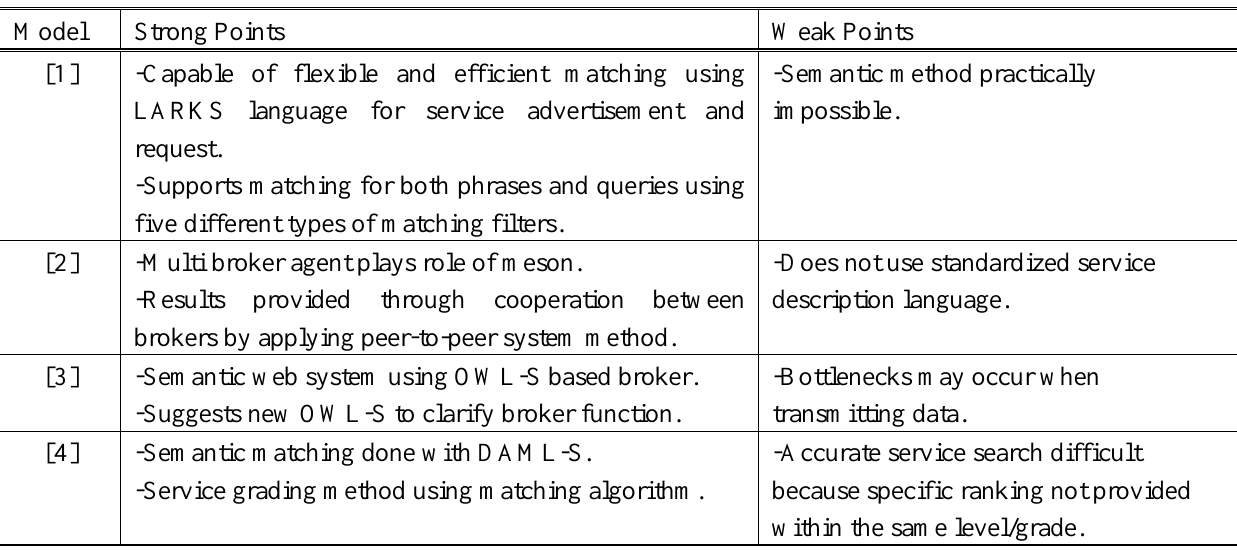
Table 1. Strong and Weak Points of Current